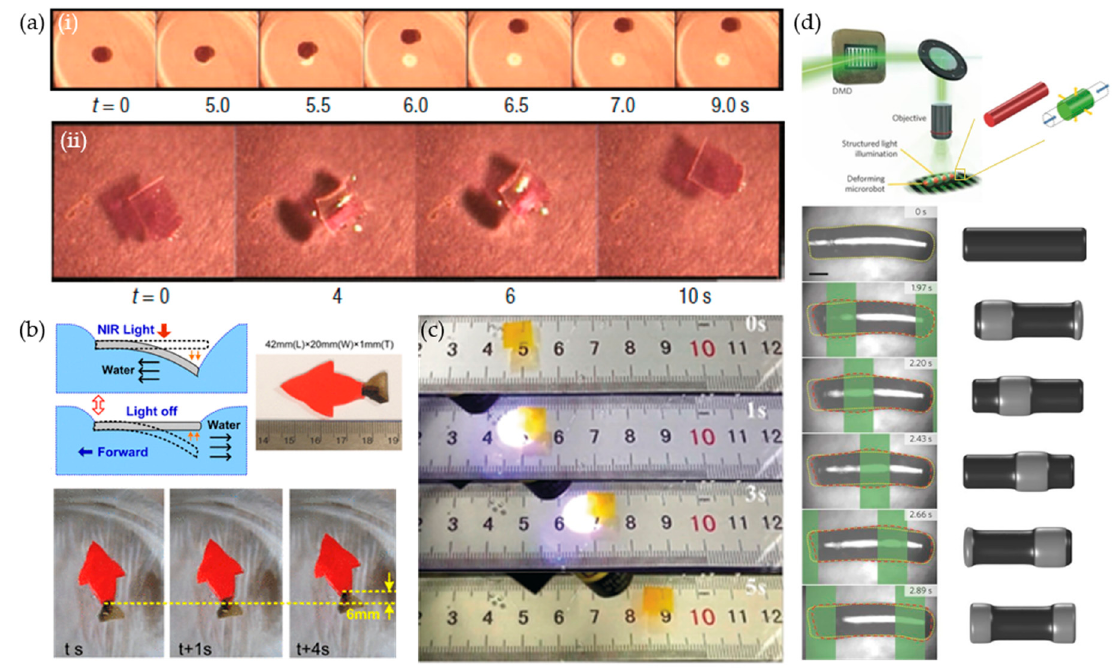
Figure 8. Swimming motion of liquid crystalline polymeric soft robots. ( a ) Photo-induced actuation of liquid crystal elastomer (LCE) on the liquid surface: ( i ) disk-shaped (5 mm in diameter, 0.32 mm in thickness) LCE on water swimming away from light (Ar + ion laser, 495 nm, 1.1 W cm − 2 ), ( ii ) rectangular-shaped LCE in ethylene glycol that folds and then swims away from the light. ( b ) Soft robotic swimmer based on polydopamine-coated LCE. Schematics of the bending/unbending of the soft robotic swimmer (up) and swimming motion of the soft robot near the air–water interface (down). ( c ) Swimming motion of an azobenzene-containing liquid crystal network (LCN)-Kapton bilayer swimmer. ( d ) A dynamic light field from a digital micromirror device is projected onto the liquid crystal polymeric soft robot (left), which propels itself in liquid through traveling-wave deformation (right). ( a ) Reproduced with permission [23]. Copyright